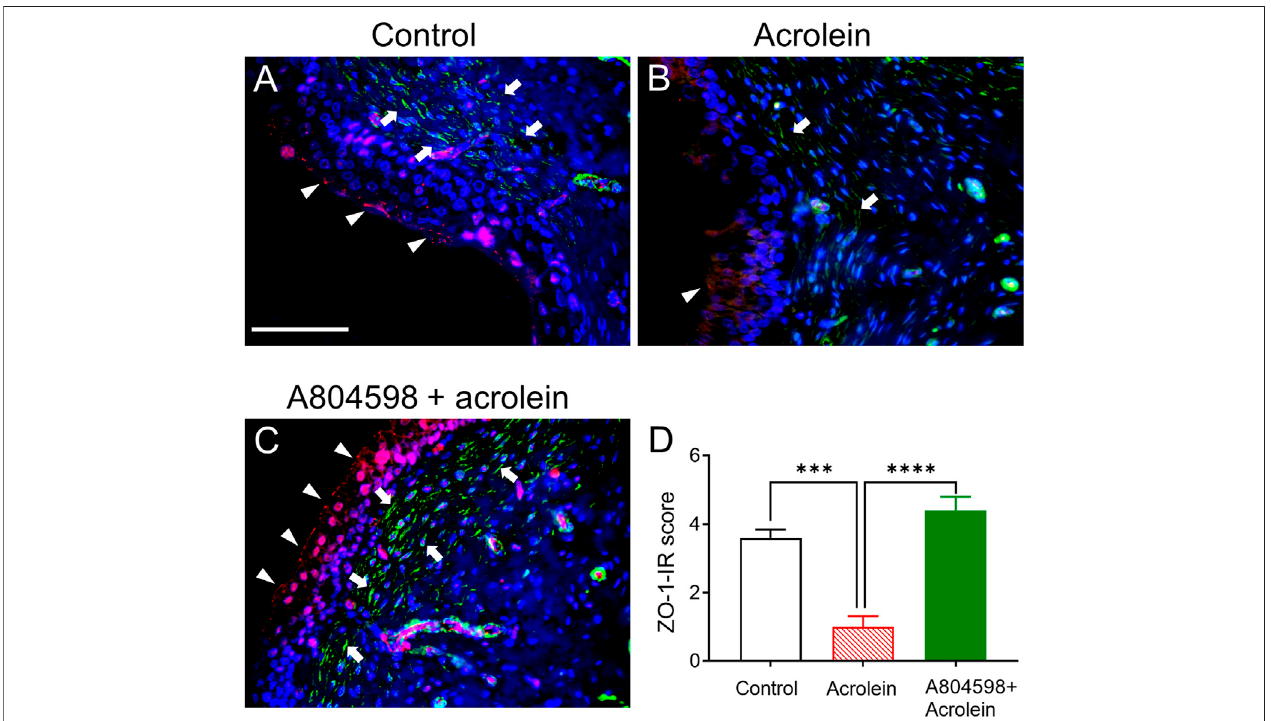
FIGURE 3 | The immunoreactivity (IR) of tight junction protein ZO-1 and α -SMA in the mucosal layer of the porcine bladders. (A) Perfusion control: ZO-1-IR (red color) was primarily observed on the luminal side of the bladder urothelium and α -SMA-IR (green color) was localized to the spindle-shaped myo fi broblasts in the sub- urothelial region. (B) Treated with acrolein (0.05%): the distribution of ZO-1 was disrupted, and it was even totally missing at many parts of the urothelium, and the α -SMA-stained myo fi broblasts were greatly reduced. (C) Treated with A804598 (10 μ M) and acrolein (0.05%). (D) Quantitative measurement of ZO-1-IR on the bladder mucosa based on the criteria described in Table 2 . The data are shown as mean ± SEM from n (cid:2) 5 bladders for each group (*** p < 0.001; **** p < 0.0001 compared to the acrolein treated group, one-way ANOVA followed by Bonferroni test). Scale bars (cid:2) 100 μ m. The arrowheads and arrows designate ZO-1-IR and α -SMA-IR, respectively. DAPI staining (blue color) shows cell